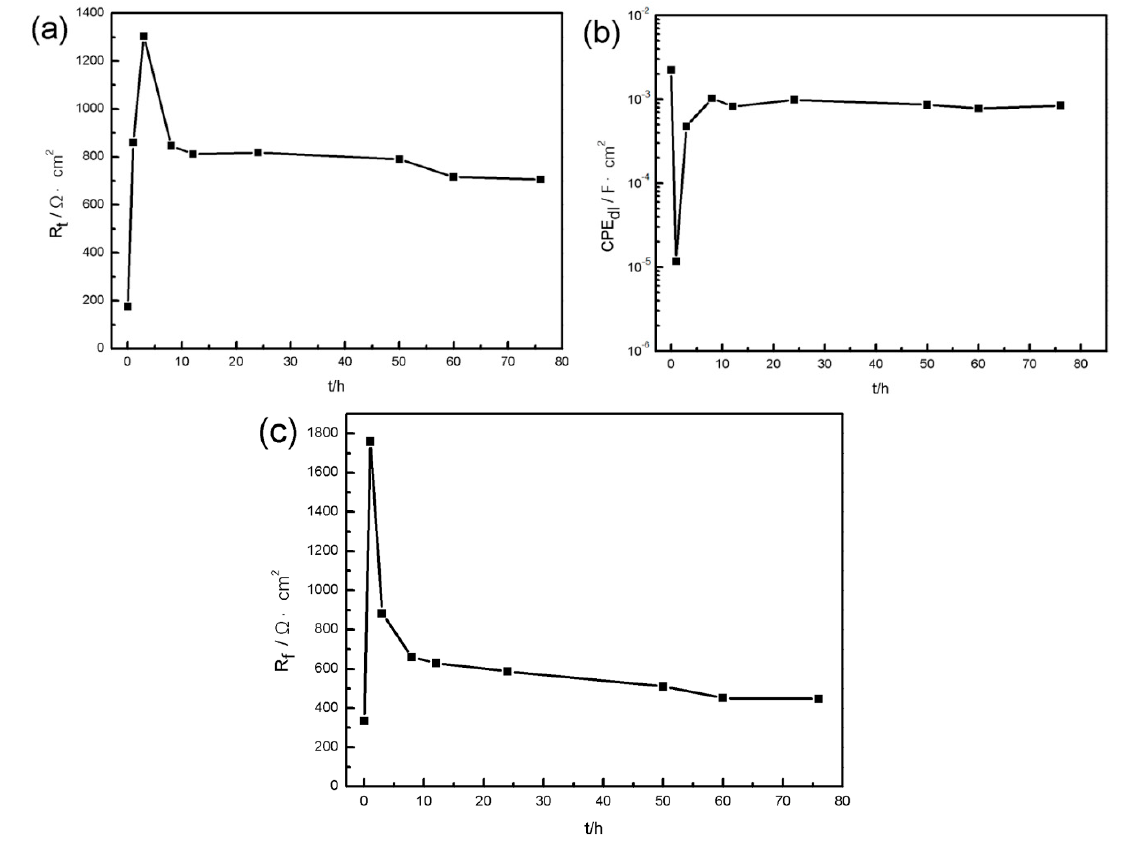
Figure 5. Fitting results of resistances and constant phase element during the immersion test: ( a ) charge transfer resistance R t , ( b ) constant phase element CPE dl , ( c ) film resistance R f .